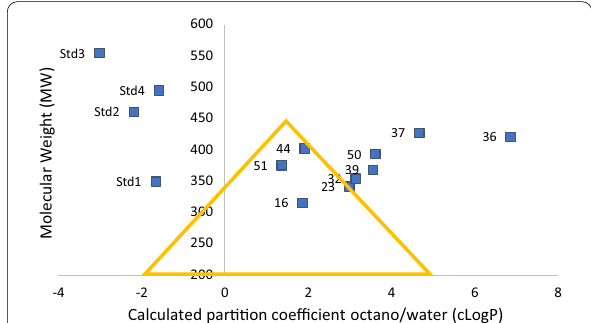
Fig. 7 Golden triangle of the reference drugs and the selected